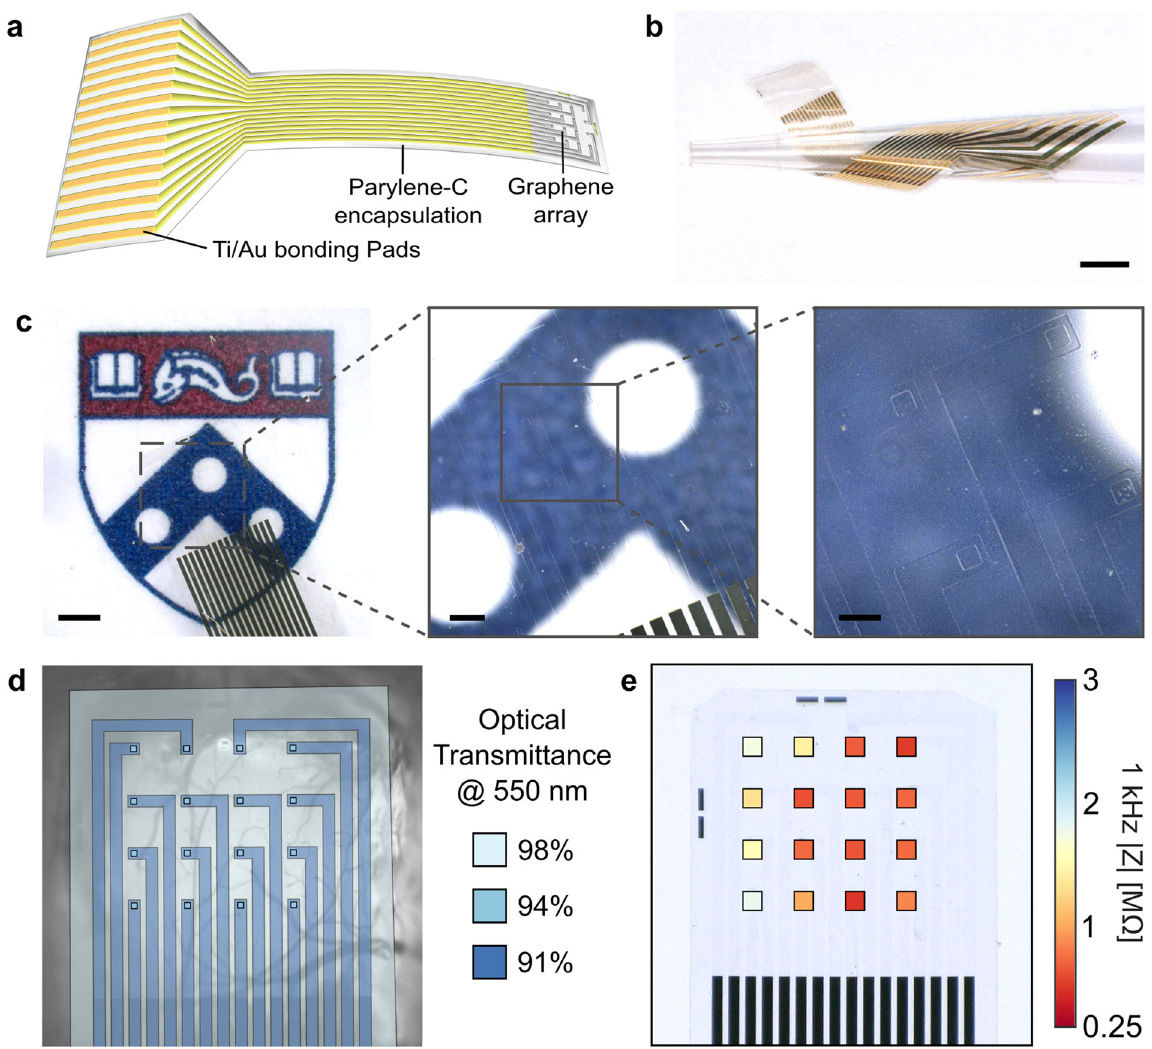
Fig. 1 Optically transparent graphene microelectrocorticography arrays. a Schematic of graphene µ ECoG device: a fully transparent array of graphene microelectrodes and traces connects to gold traces in a fl exible cable, which can be interfaced with a data acquisition system through a ZIF connector. b A graphene µ ECoG device wrapped around a pipette tip to demonstrate its fl exibility. Scale bar: 2 mm. c Images of the graphene electrode array overlaid on the Penn logo to demonstrate optical transparency. Scale bars, left to right: 1 mm, 250 μ m, and 100 μ m. d Optical transmittance at 550 nm for different locations in the graphene µ ECoG array. Overall, the device is >90% transparent across the visible to near infrared spectrum. e 1 kHz impedance magnitude for each 50 μ m × 50 μ m transparent graphene electrode in the array, averaged over three devices. Values are overlaid in the corresponding electrode locations on a light microscopy image of a single device. For clarity, electrodes are not shown to (Fig. 1d and Supplementary Fig. S3). The average impedance over four such devices ( n = 64 channels) was 908 ± 488 k Ω at the 1 kHz reference frequency (Fig. 1e and Supplementary Fig. S2), which corresponds to an area-normalized impedance of 22.7 ± 12.2 Ω ·cm 2 .